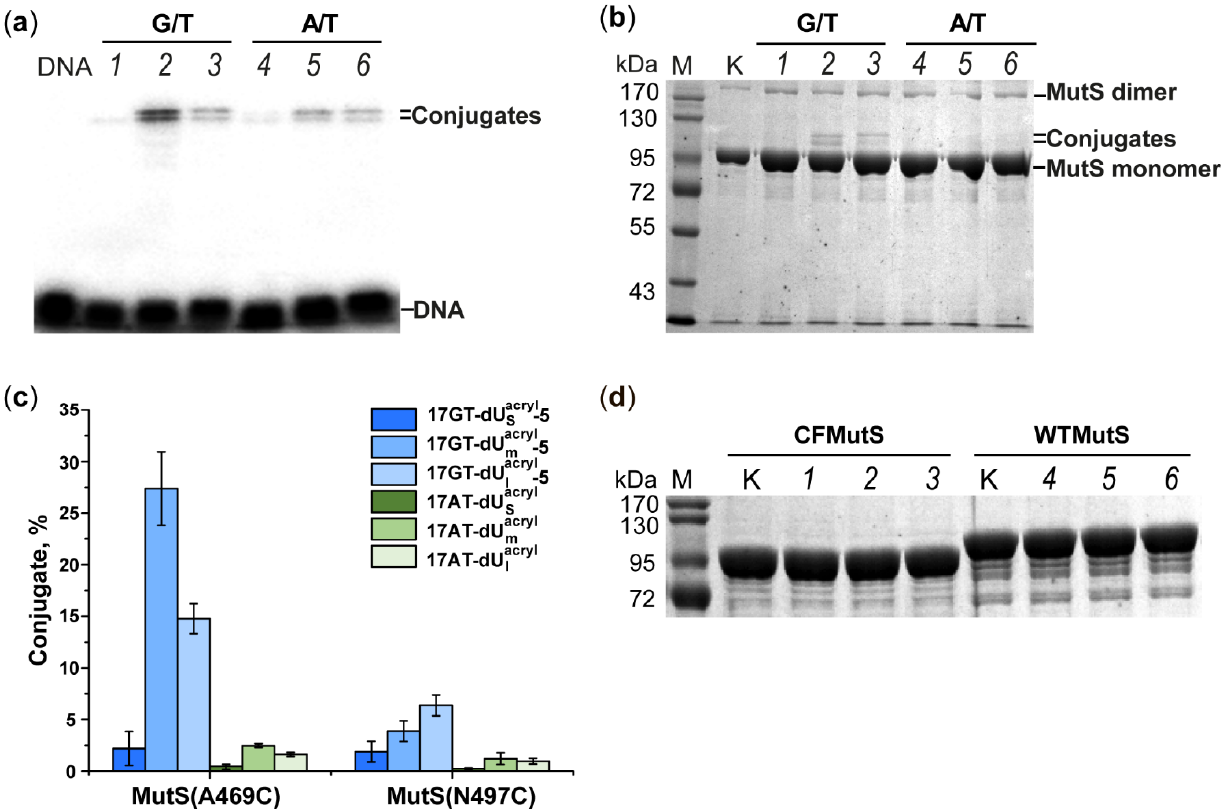
Figure 5. Cross-linking of MutS(A469C), MutS(N497C), CFMutS or WTMutS (5 µM on the monomer basis) with DNA duplex 17GT-dU sacryl -5 , 17GT-dU macryl -5 , 17GT-dU lacryl -5 , 17AT-dU sacryl , 17AT-dU macryl or 17AT-dU lacryl (0.5 µM) containing a 32 P label at the 5 ′ end of the modified strand. Analysis by 8% polyacrylamide gel electrophoresis (PAGE) with 0.1% of SDS. Autoradiograph ( a ) and photographs ( b , d ) of the gels stained with a Coomassie G250 solution. ( a , b ) Lanes 1 – 6 : products of MutS(A469C) cross-linking with duplex 17GT-dU sacryl -5 , 17GT-dU macryl -5 , 17GT-dU lacryl -5 , 17AT-dU sacryl , 17AT-dU macryl or 17AT-dU lacryl , respectively. ( c ) Efficiency of a MutS(A469C) or MutS(N497C) reaction with 17GT-dU nacryl -5 or 17AT-dU nacryl . The error bars represent the standard deviation of three independent experiments; p < 0.05. ( d ) Interaction of CFMutS (lanes 1 – 3 ) or WTMutS (lanes 4 – 6 ) with 17GT-dU sacryl -5 , 17GT-dU macryl -5 or 17GT-dU lacryl -5 . Lanes K correspond to the protein without DNA; DNA lane: 17GT , M: markers of protein molecular mass, kDa.